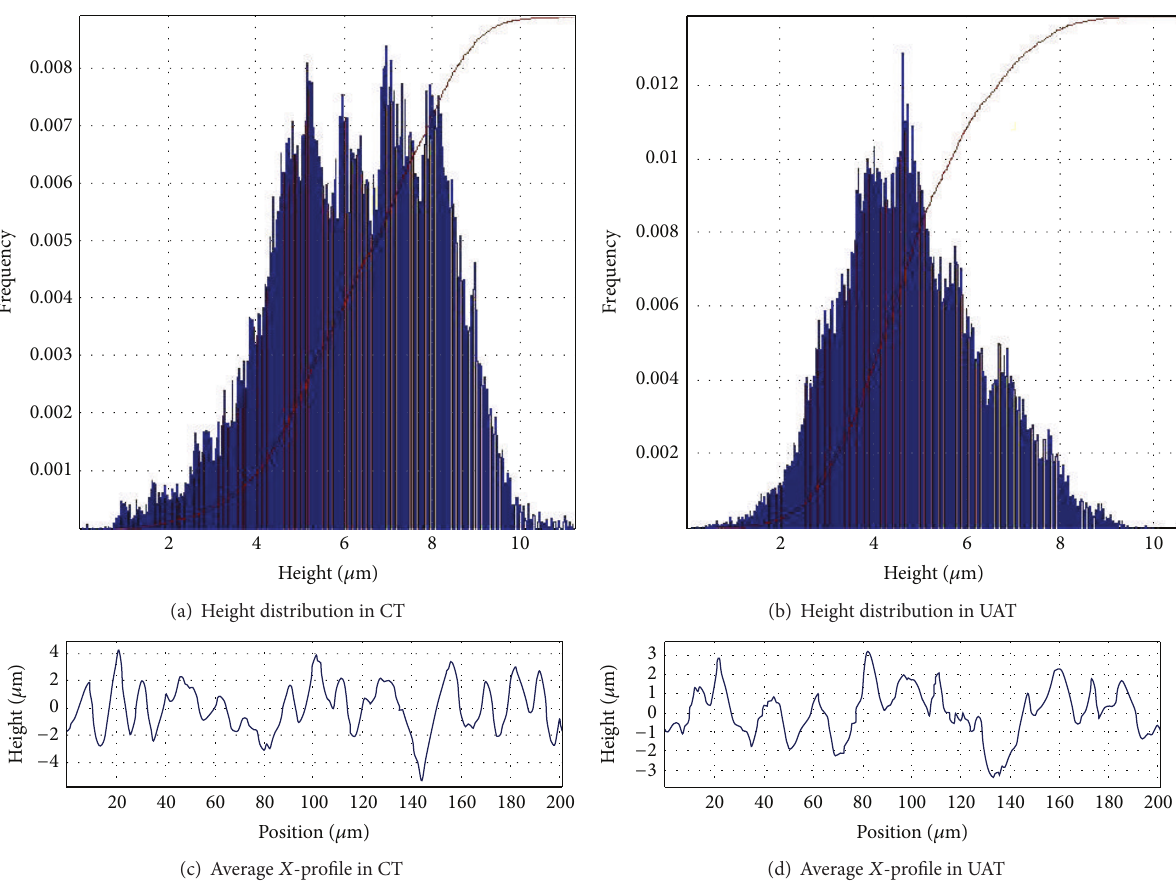
Figure 14: Height distribution histogram and average 𝑋 -profile of the main